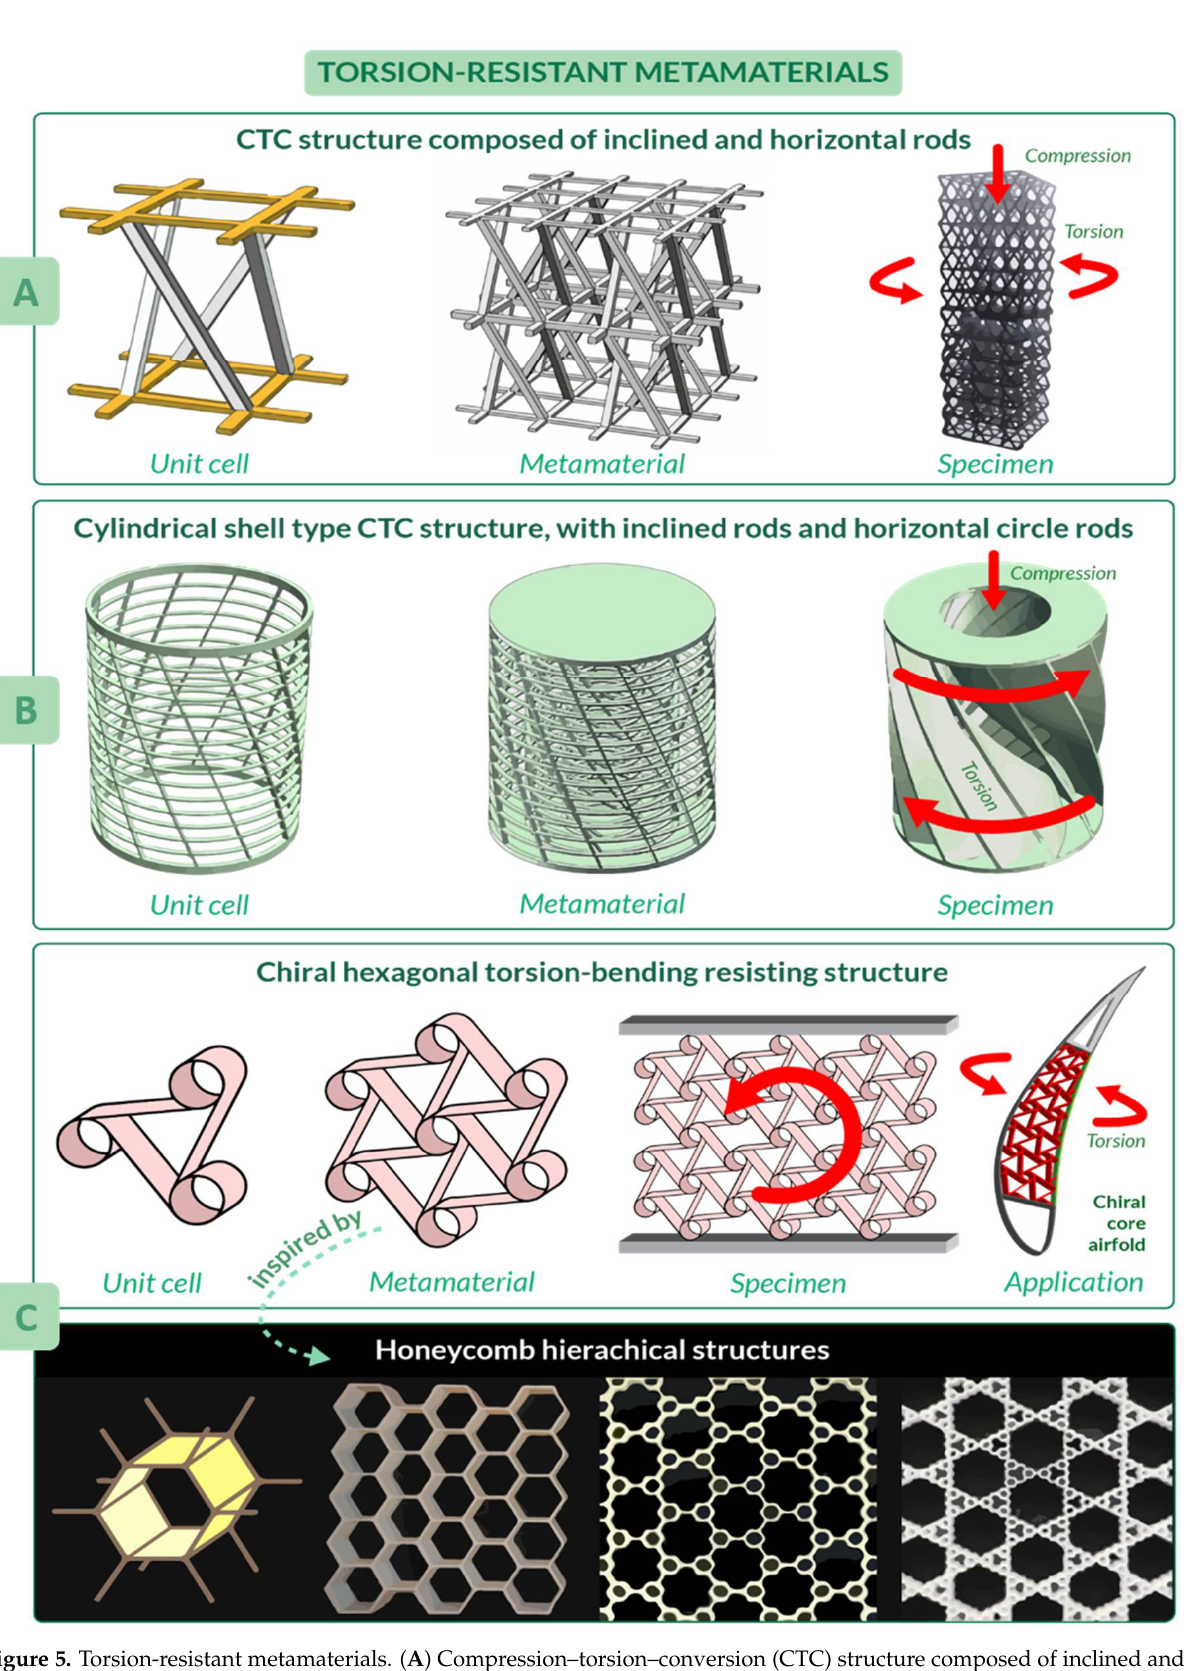
Figure 5. Torsion-resistant metamaterials. ( A ) Compression–torsion–conversion (CTC) structure composed of inclined and horizontal rods. ( B ) Cylindrical shell type CTC structure. ( C ) Chiral hexagon torsion-bending resistant